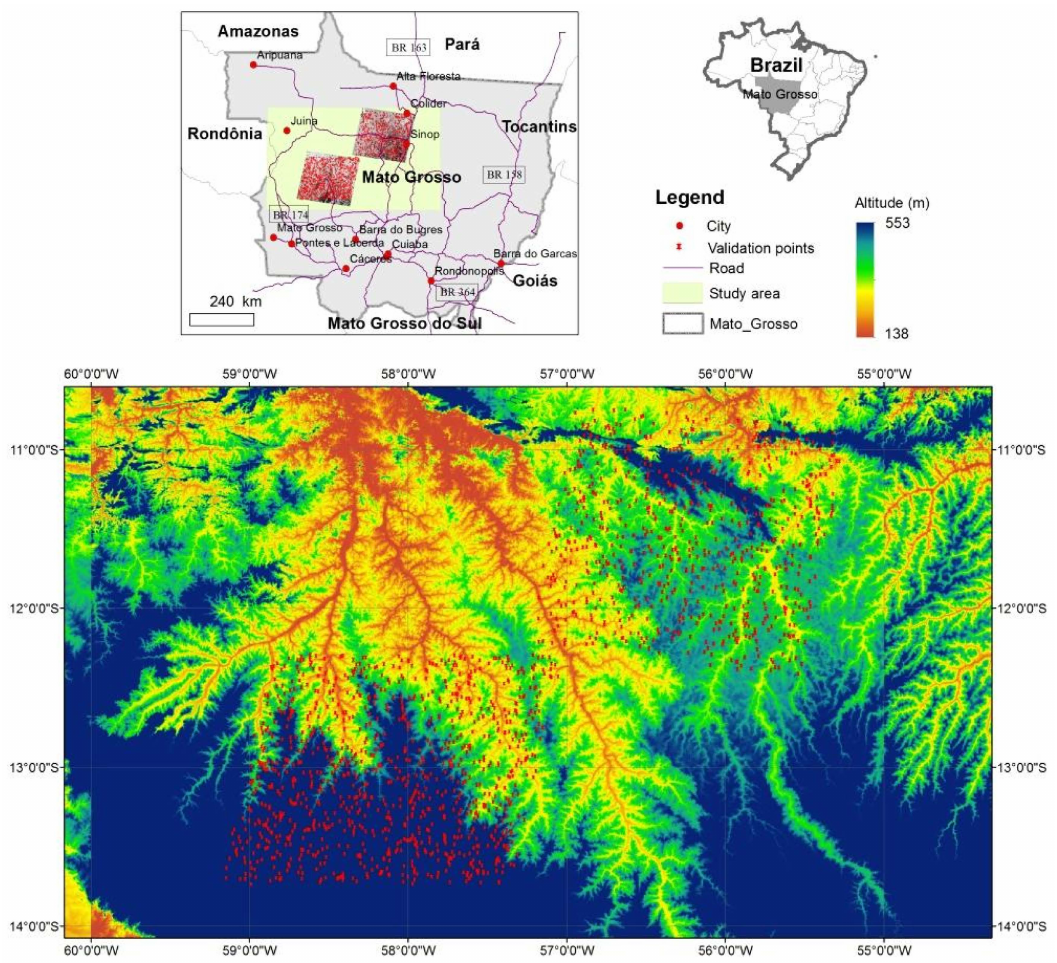
Figure 1. Study area—part of Mato Grosso State,